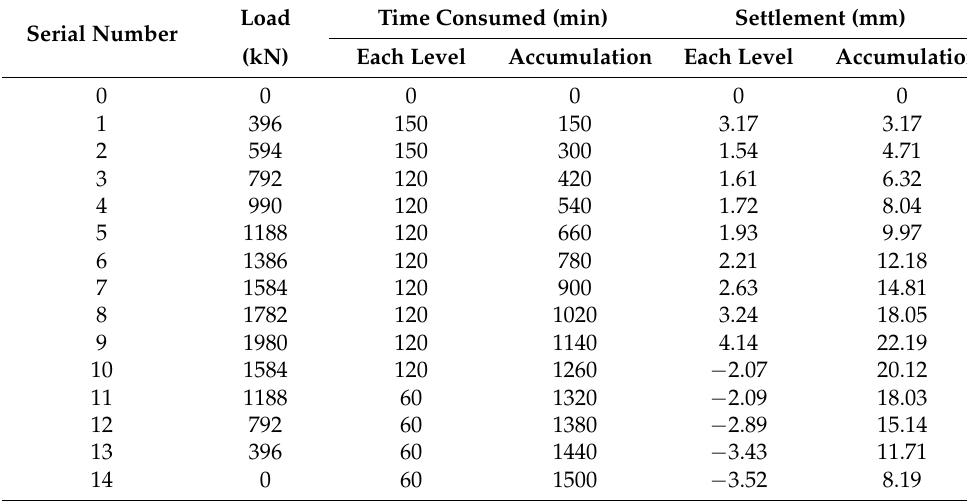
Table 1. Settlement result table of No. 2-8# pile under graded